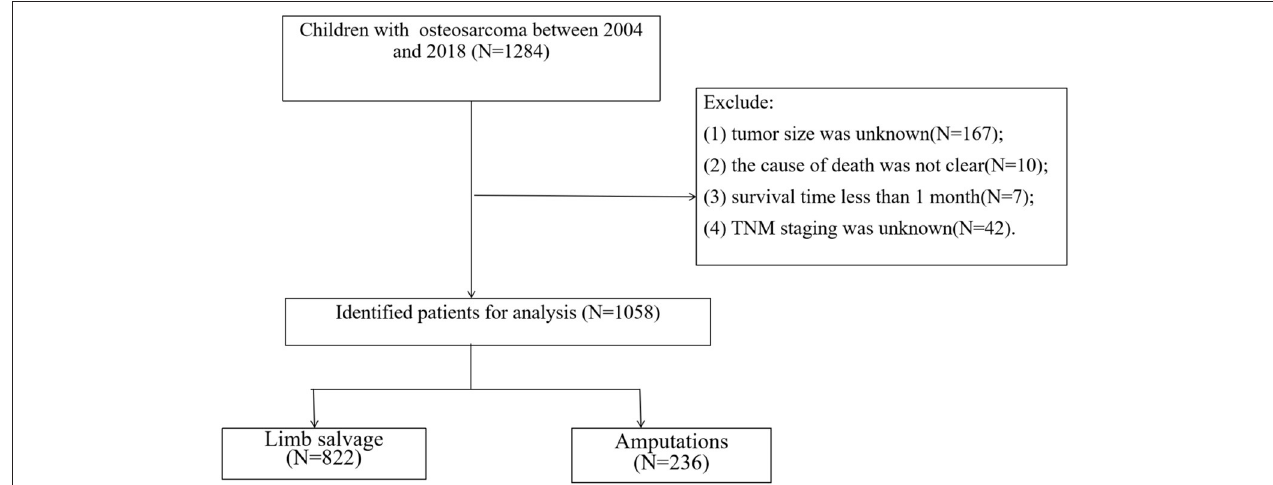
FIGURE 1 | CONSORT (Consolidated Standards of Reporting Trials) diagram of study inclusion